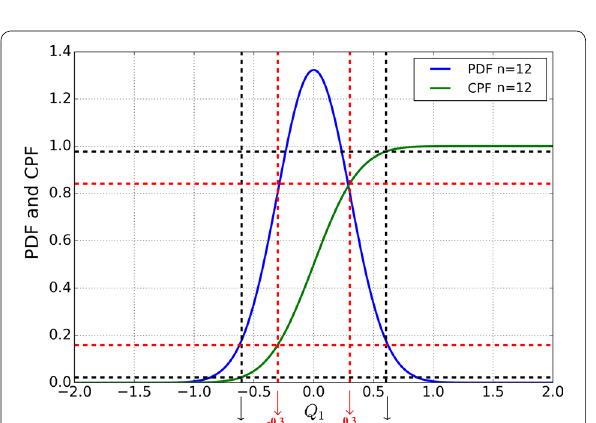
Fig. 5 Probability density function and cumulative probability Fig. 4 Probability density function and cumulative probability function for the Q 2 variable. Example of PDF and CPF for Q 2 for function for the Q 1 variable. Example of PDF (solid blue line) n 12. The black dashed horizontal lines intersect the CPF at and CPF (solid green line) for Q 1 , for n 12. Red and black = = the two points of coordinates ( L , 0.025) and ( U , 0.975), while the arrows (corresponding to red and black dashed vertical lines) red dashed horizontal lines intersect the CPF at the two points of indicate, respectively, the thresholds 1 σ and 2 σ . Black and ± ± coordinates ( L 1st , 0.25) and ( U 3rd , 0.75), where L 1st and U 3rd identify the red dashed horizontal lines represent the values referred to the first and third quartile, respectively. As a consequence, the black and CPF corresponding to the conditions (20) and (21) which, for the red arrows mark the intervals of the variable Q 2 corresponding to a considered case, provide, respectively, the numerical solutions statistical significance of 95% and 50%, 0.60 < Q 1 < 0.60 and 0.30 < Q 1 < 0.30 − + − +